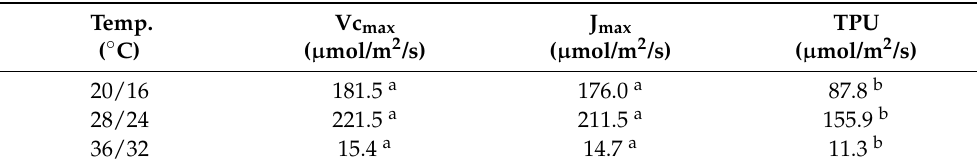
Table 2. Photosynthetic characteristics of Chinese cabbage grown at 20 ◦ C, 28 ◦ C, and 36 ◦ C for eight days.